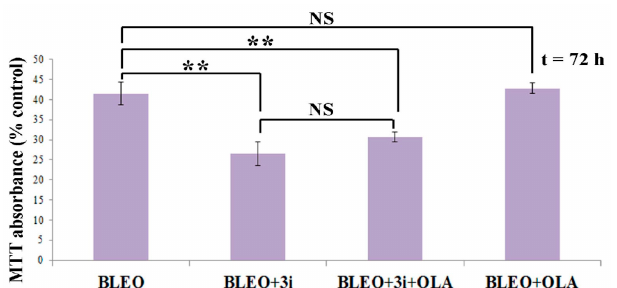
NS: statistical non-significance. Although not represented in the graph, 3i was toxic by itself (cell viability = 66.82 ±